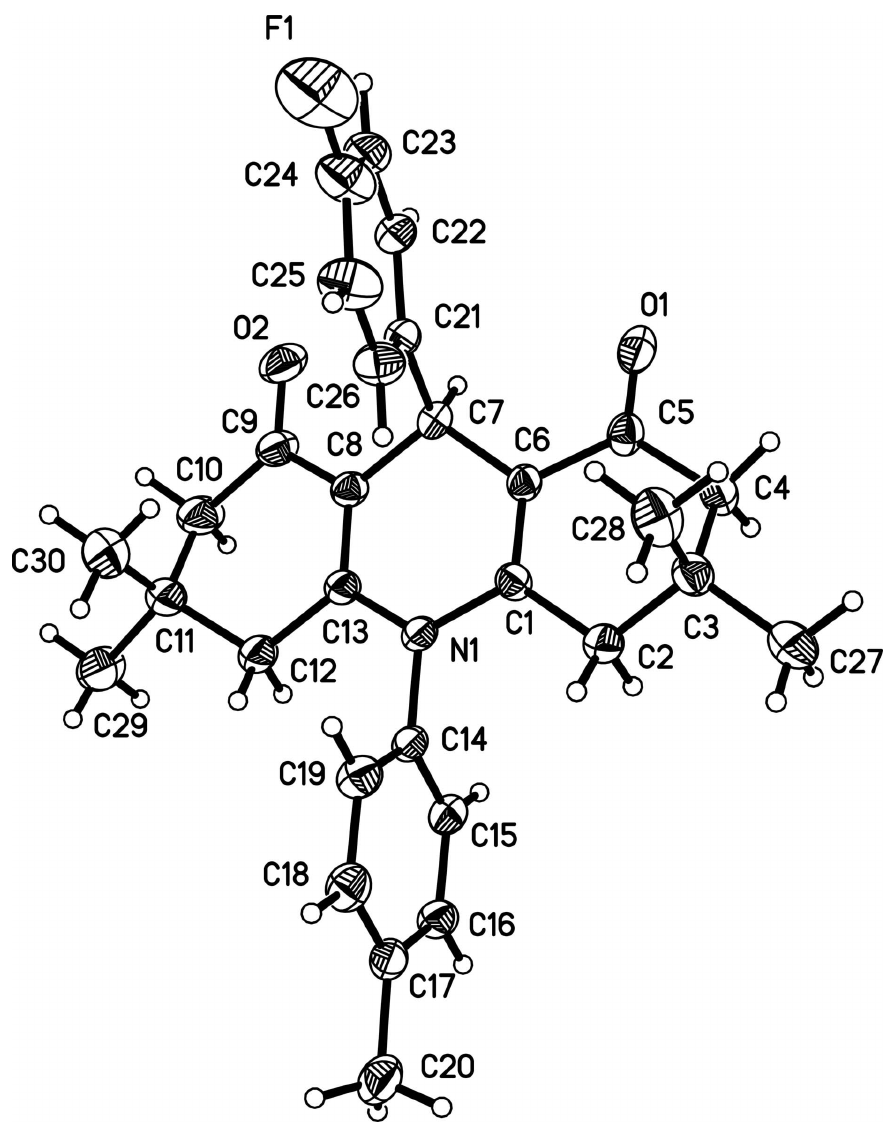
Figure 1 The molecular structure of the title molecule, with the atom-numbering scheme. Displacement ellipsoids are drawn at the 30% probability